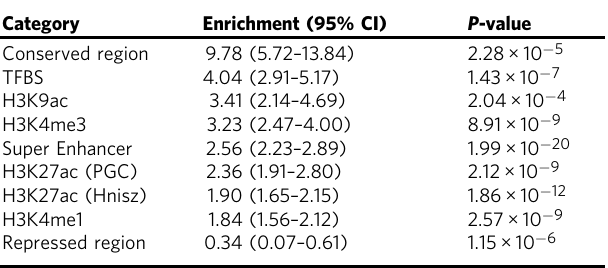
Table 1 Signi fi cant enrichment estimates of genomic functional categories, meta-analyzed across six cancer